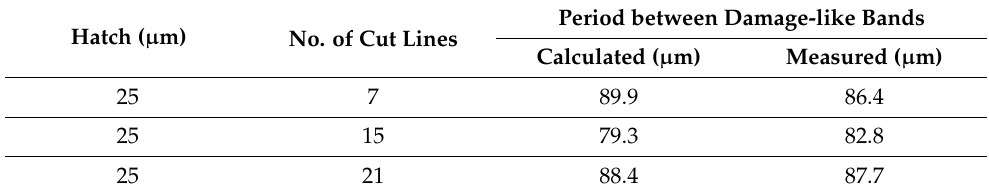
Table 4. The distance (period) between the individual band-like damages formed during glass cutting in ambient air. Hatch ( µ m) No. of Cut Lines